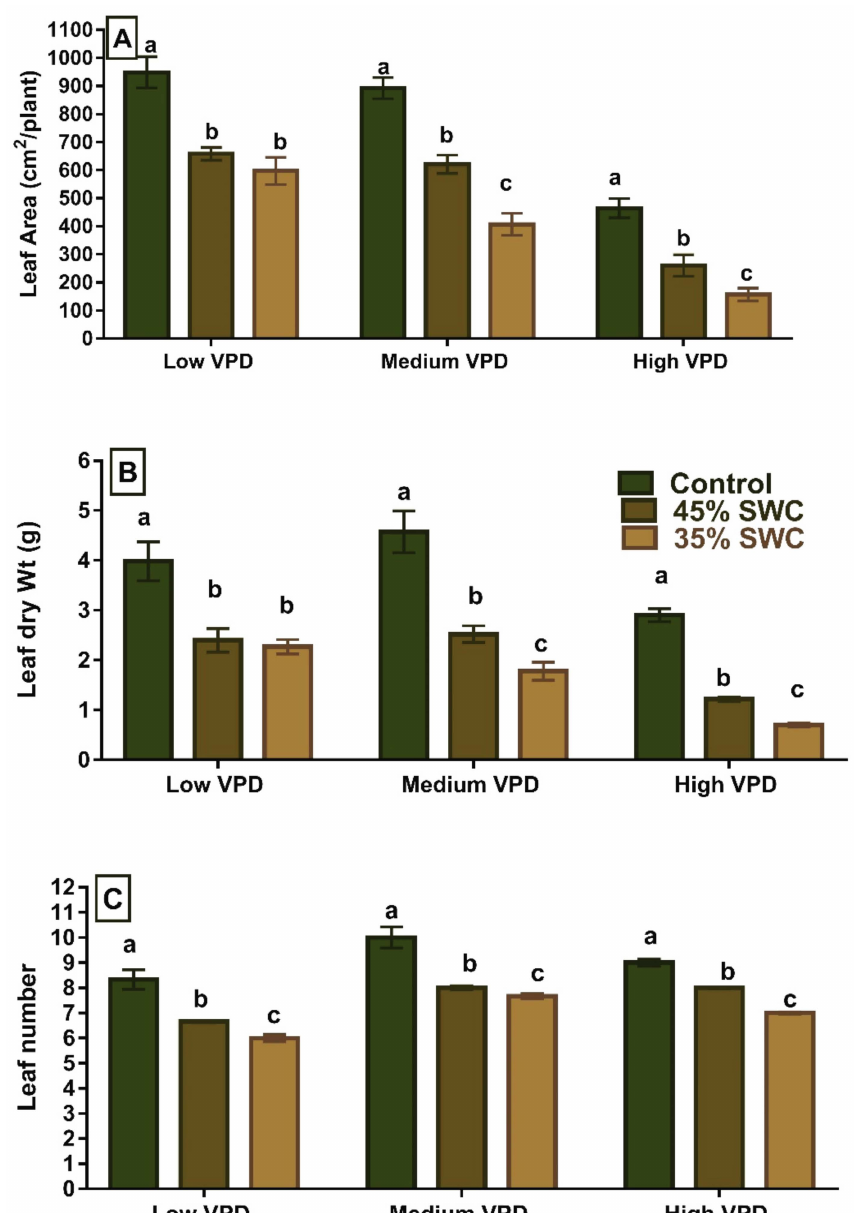
Figure 1. Average ( A ) Leaf area (cm 2 /plant) and ( B ) Leaf dry wt. (g/plant) and ( C ) Leaf number of maize under low, medium and high vapor pressure deficit (VPD) conditions to three different soil water levels (Well-Watered, 45% Soil water content (SWC), and 35% SWC). The bars ( ± average) represented by the same alphabet were not significant at p < 0.05 based on Tukey’s Kramer method at that particular VPD